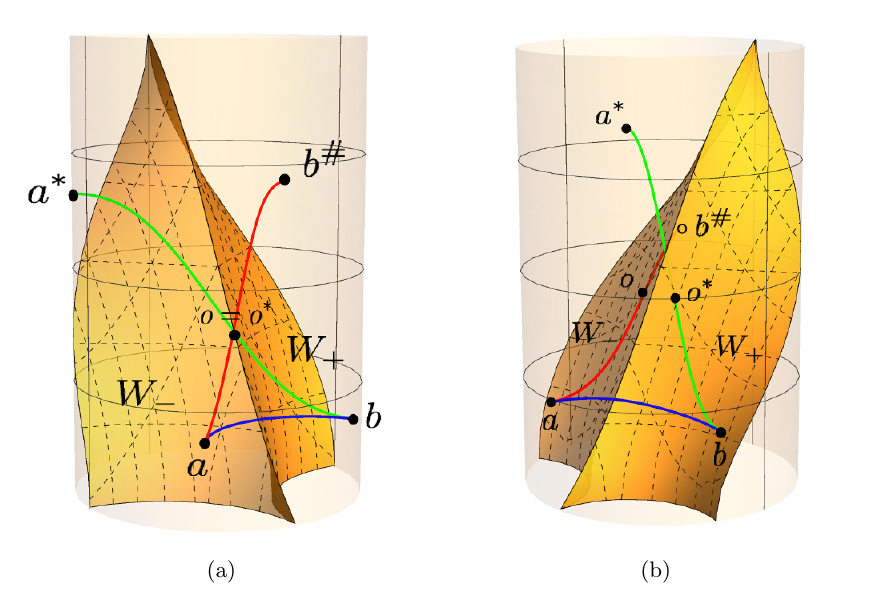
Figure 11 . Direct and crossing geodesics in global coordinates. (a) The moment (cid:28) = (cid:0) 0 : 86 when the symmetric direct geodesic with (cid:30) b = (cid:0) (cid:30) a = 0 : 614 emerges coincides with the moment of vanishing of the corresponding crossing geodesic. Here R = 5. (b) The case of non-symmetric geodesics: the direct geodesic with (cid:30) a = (cid:0) 0 : 1, (cid:30) b = 1 : 182, (cid:28) a = (cid:0) 0 : 816, (cid:28) b = (cid:0) 0 : 928 exists, whereas the corresponding crossing geodesic has not yet vanished as well; R = 0 :